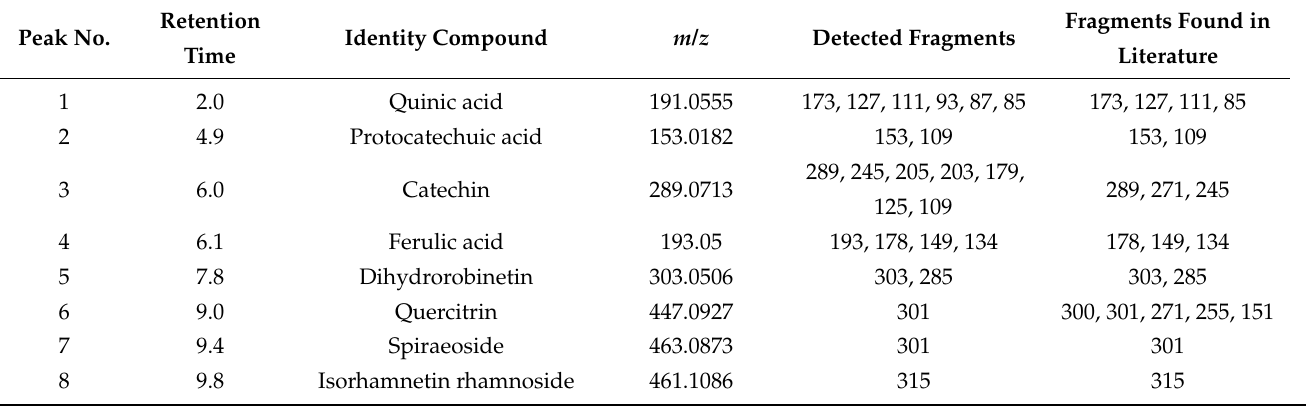
Table 1. Identity of discernible peaks found with DAD analysis combined with targeted mass spec ‐ trometry .